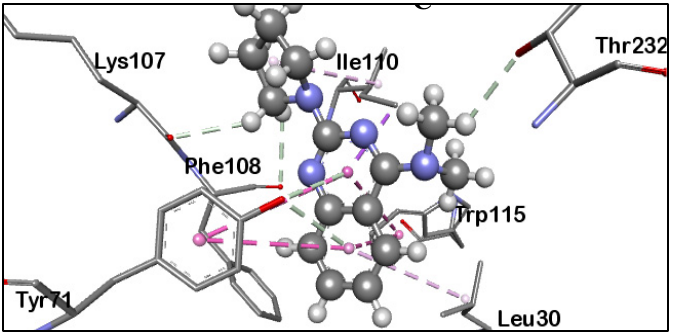
Figure 3. Zoomed-in 3D snapshot of BACE1 crystal structure complexed with compound 12 (PDB code: 5MXD) devoid of Asp32/228 interaction [32]. The compound binds at the flap region of BACE1 and we generated this image with the Discovery Studio R2017 [35].